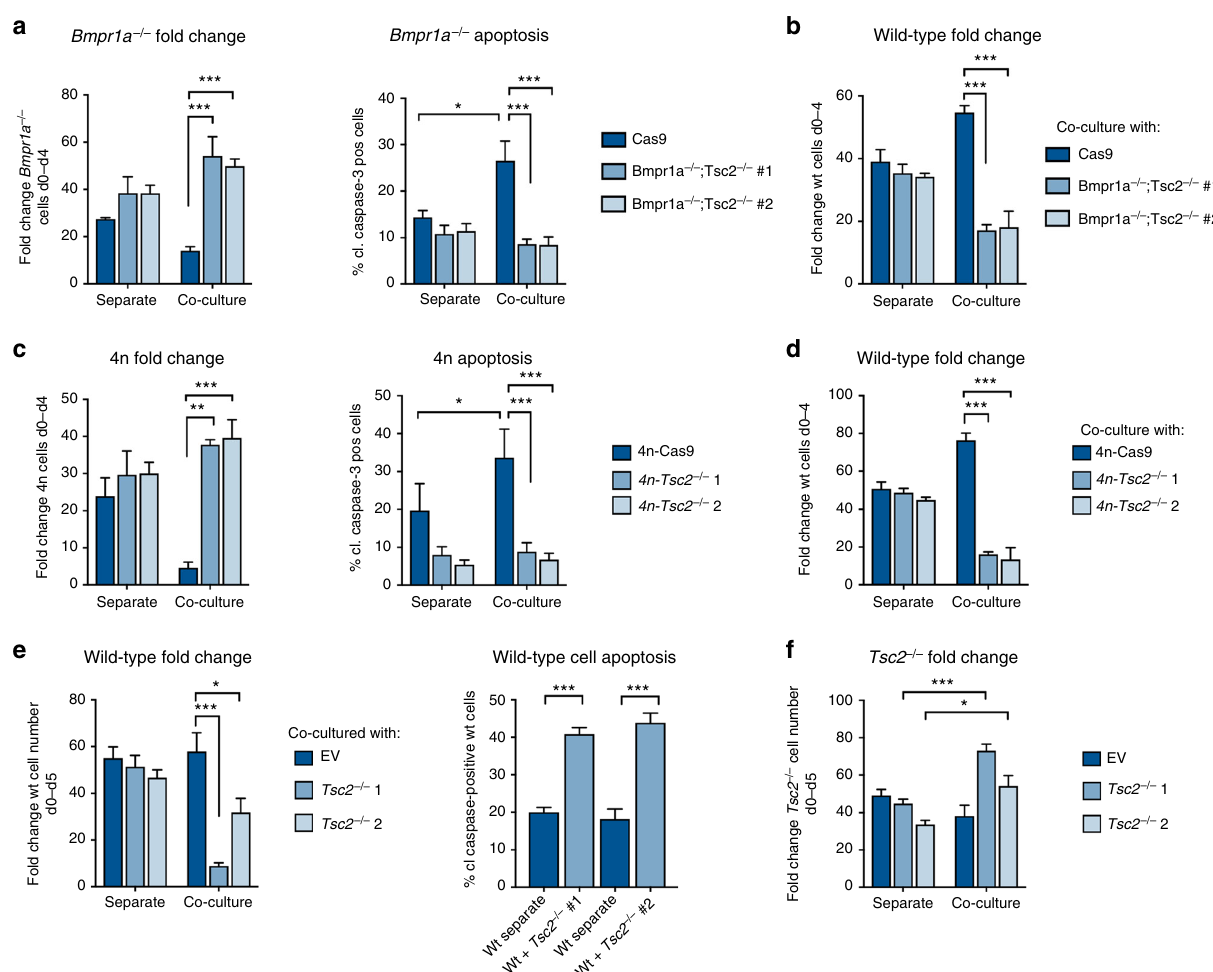
Fig. 3 Constitutive activation of the mTOR pathway in defective cells rescues their elimination during competition. a Fold change in Bmpr1a − / − and Bmpr1a − / − ; Tsc2 − / − (two independent clones) cell numbers between d0 – d4 and percent of cleaved caspase-3 positive cells at day 4 cells when cultured alone (separate) or with wild-type cells in N2B27. b Fold change in wild-type cell numbers between d0-d4 when cultured separately or co-cultured with Bmpr1a − / − or Bmpr1a − / − ; Tsc2 − / − cells. c Fold change in 4n and 4n; Tsc2 − / − (two separate independent clones) cell numbers between d0 – d4 and percent of cleaved of caspase-3 positive cells at day 4 when cultured separately or with wild-type cells in N2B27. d Fold change in wild-type cell numbers between d0 – d4 when cultured separately or co-cultured with 4n or 4n; Tsc2 − / − cells. e Fold change in wild-type cell numbers between d0 – d4 and percent of cleaved caspase-3 positive cells at day 4 when cultured separately or co-cultured with Cas9 or Tsc2 − / − cells (two independent clones) in N2B27. f Fold change in Tsc2 − / − cell numbers between d0 – d5 when cultured separately or co-cultured with wild-type cells. n = 3 for all studies. Error bars denote SEM. * p < 0.05, ** p < 0.01 and *** p < 0.005; ANOVA and Tukeys post-hoc